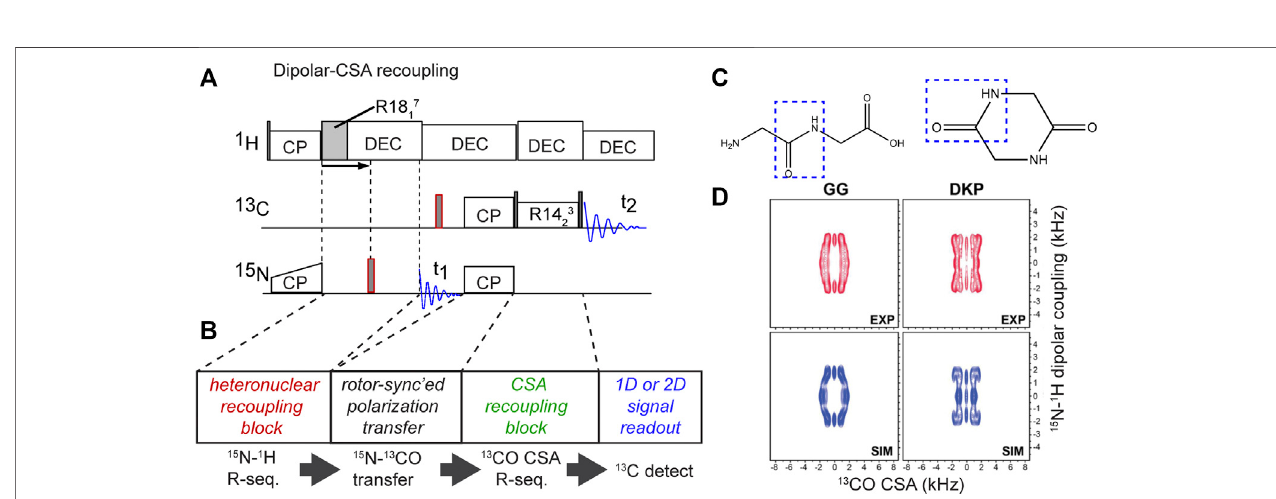
FIGURE 9 | Hybrid CSA/dipolar recoupling experiment. (A) Pulse sequence and (B) its building blocks. (C) Chemical structures of test molecules with different molecular con fi gurations mimicking the cis or trans peptide bond angle ω . (D) 2D CSA-dipolar correlation spectra for the two reference compounds representing the distinct ω angles. Panel (D) was adapted with permission from ref. (Mukhopadhyay et al.,